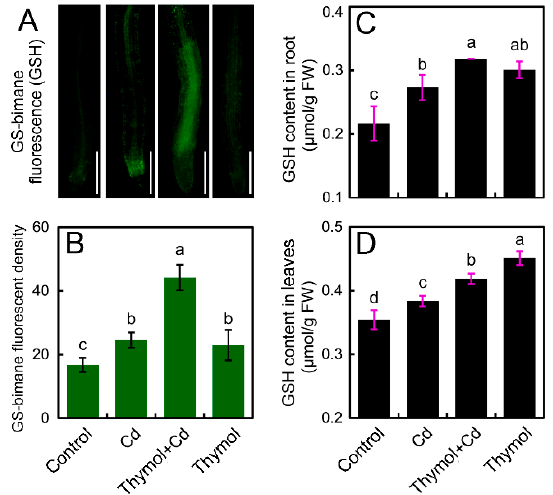
Figure 7. The effect of thymol on GSH content in tobacco seedlings under Cd stress. The roots of seedlings were treated with water (control), CdCl 2 (20 μ M), CdCl 2 (20 μ M) + thymol (100 μ M), and thymol (100 μ M) for 72 h. Then the roots were loaded with monochlorobimane for the observation of green fluorescence ( A ) and the quantification of fluorescent density ( B ). Bar = 1 mm. The GSH content was determined by in-tube assay in roots ( C ) and leaves ( D ), respectively. Different letters in ( B – D ) indicate that the mean values of three replicates are significantly different between the treatments ( p < 0.05, ANOVA, LSD).